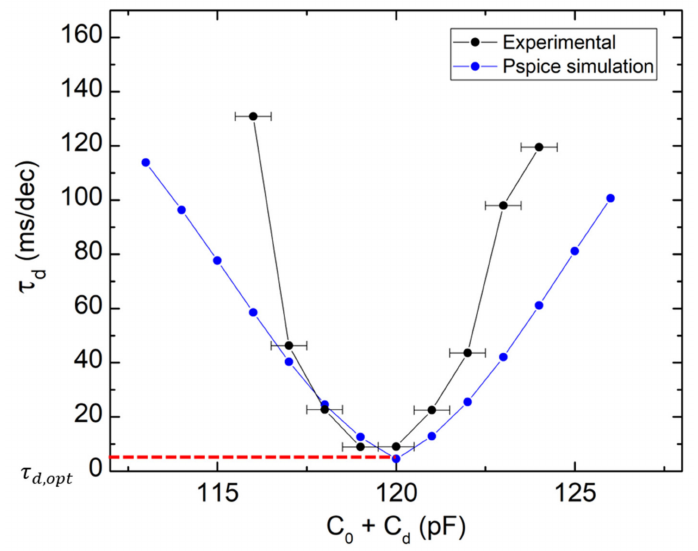
Figure 5. Evolution of the decay time as a function of the effective damping capacitance, comparing the experiment (black dots) with the PSPICE simulation (blue dots). The optimum decay time is of 9.0 and 4.5 ms/dec, for the experiment and the simulation,